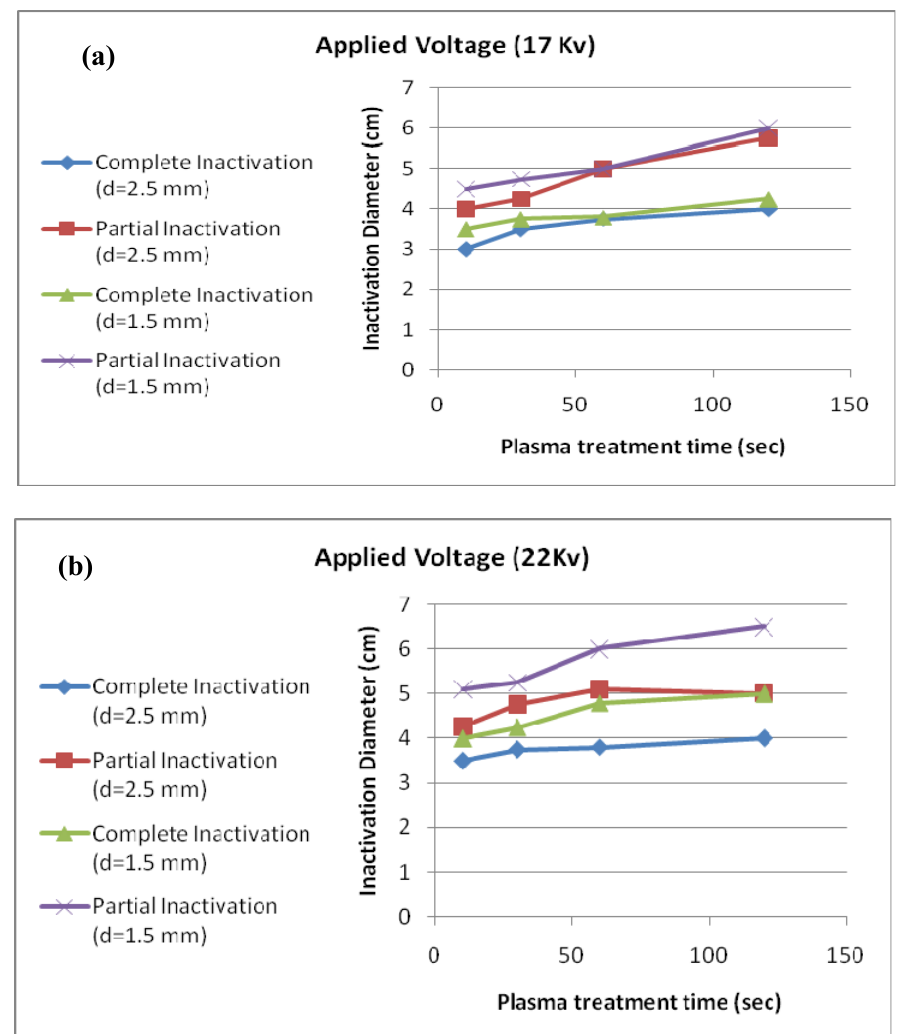
Fig. 5: The complete and partial inactivation diameter for Staphylococcus spp Bacteria as a function of the DBD plasma time treatment at 1.5mm and 2.4mm gap distance when the applied voltages are a) 17kV and b)